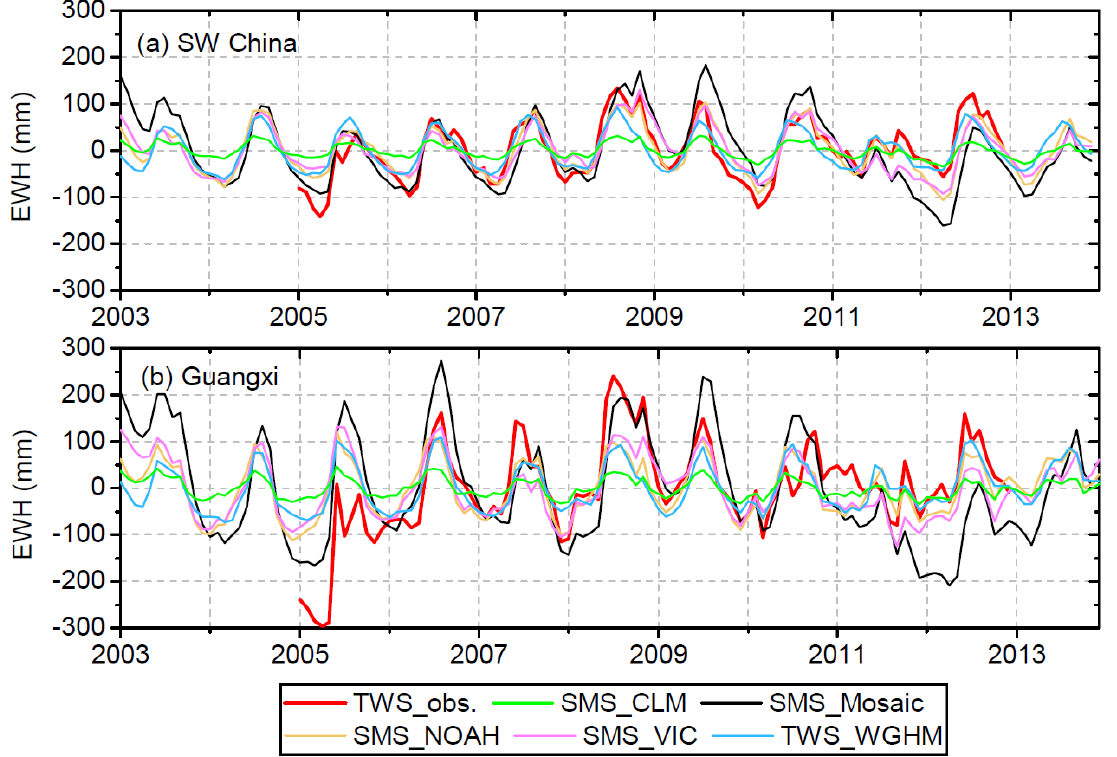
Figure 3. Comparison of simulated SMS from GLDAS models and TWS from WGHM with in situ observations of TWS.